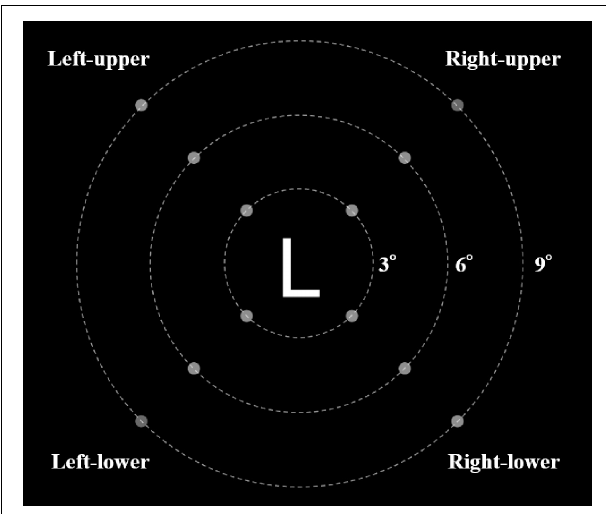
FIGURE 2 | A sequence in a single trial (luminance change in this example occurred in the right-upper quadrant at an eccentricity of 9 ◦